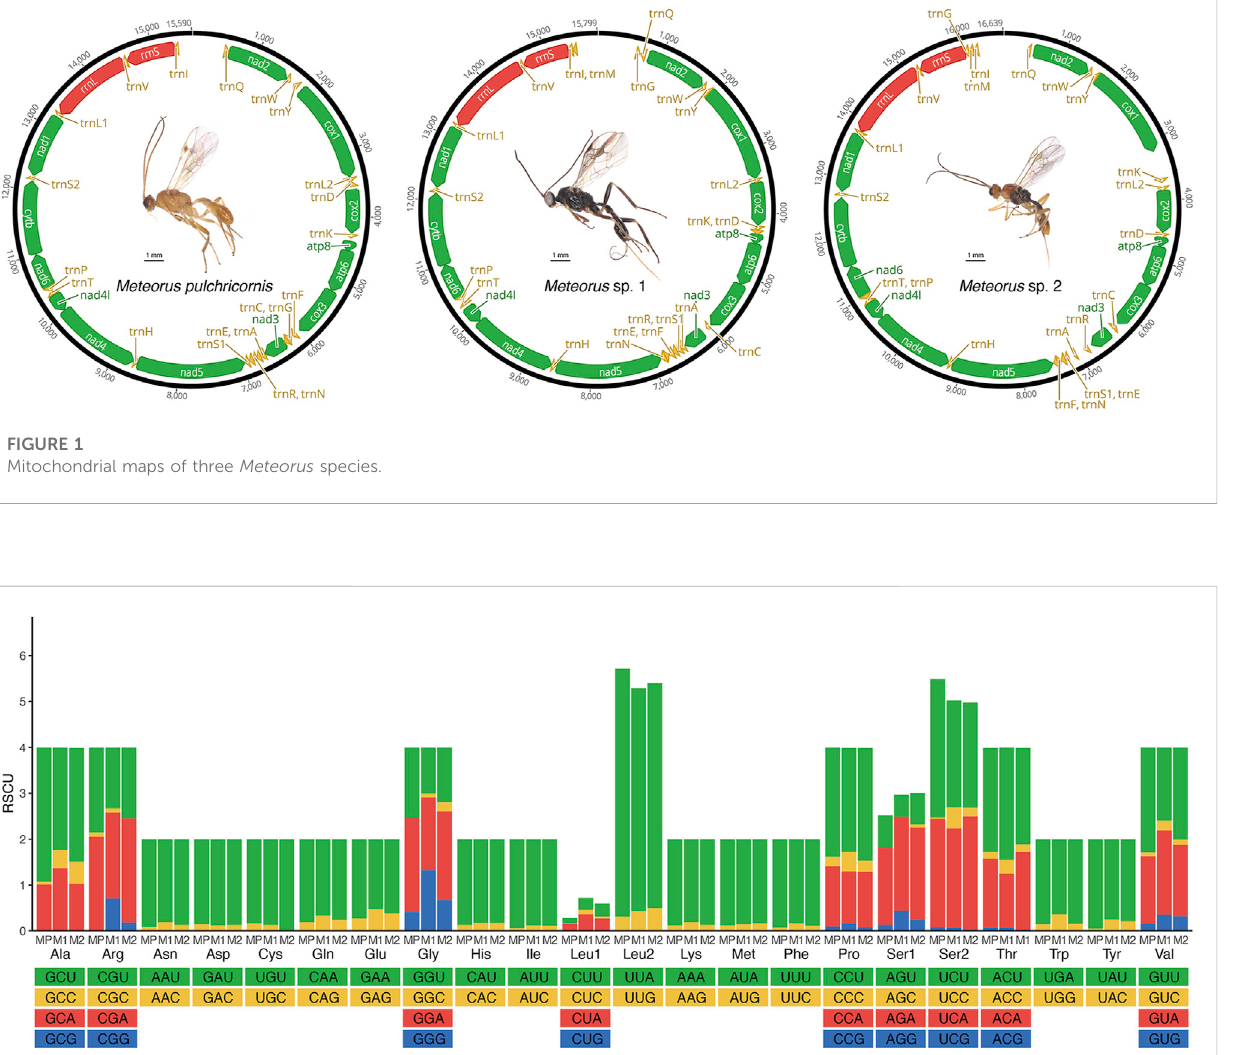
FIGURE 2 Relative synonymous codon usage (RSCU) of three Meteorus species. Codon families are provided on the X -axis along with the different combinations of synonymous codons that code for that amino acid. RSCU is de fi ned on the Y -axis. MP, Meteorus pulchricornis ; M1, Meteorus sp. 1; M2, Meteorus sp.